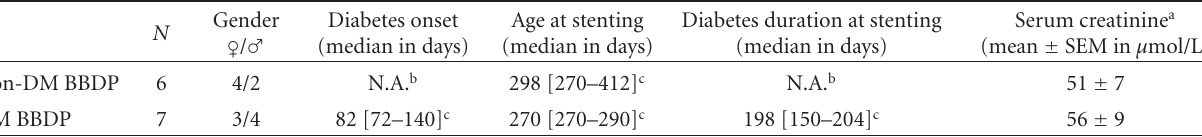
Table 1: Characteristics of the diabetic (DM) and thymectomized non-diabetic (non-DM) BBDP rats that were stented and evaluated for the development of in-stent